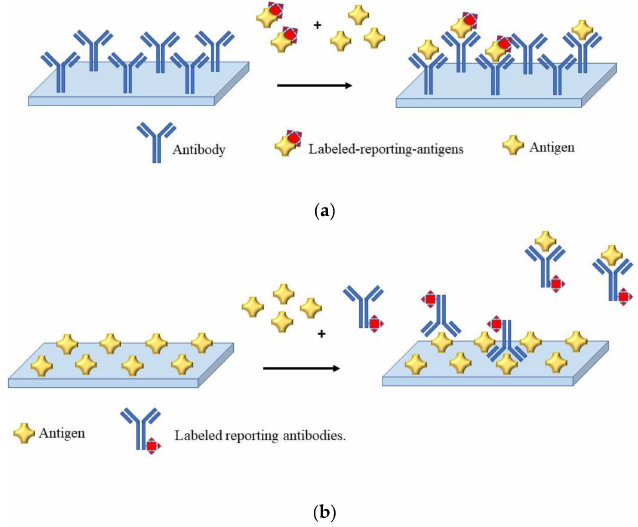
Figure 1. Schematic representation of a competitive immunoassay. ( a ) The antibody is immobilized; ( b ) the antigen is